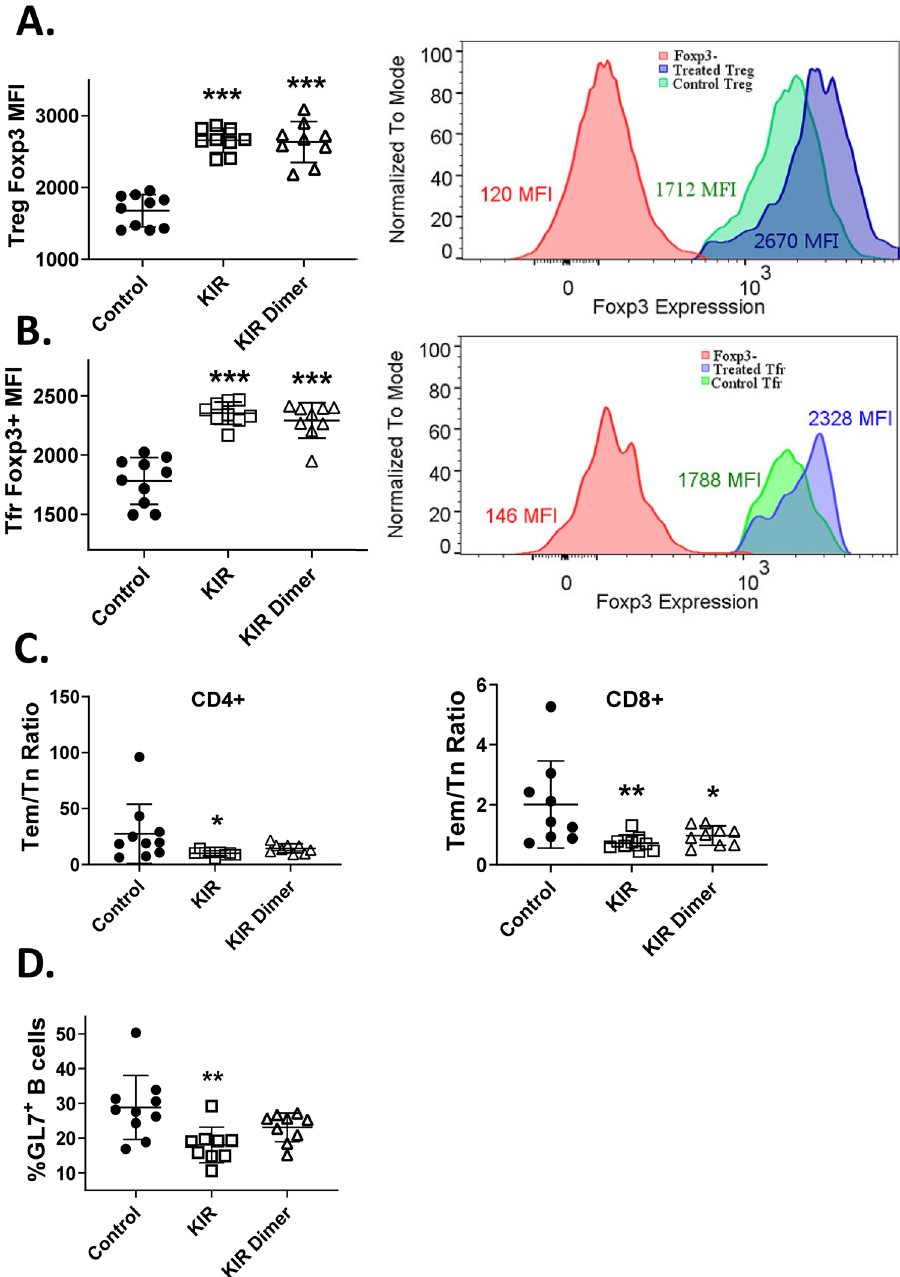
( B ) CD4 + T follicular regulatory cells [CD4 + PD1 + CXCR5 + Bcl6 + Foxp3 + ] were analyzed by flow cytometry. ( C ) Ratio of CD4 + and CD8 + effector memory (CD44 + CD62L − ) to naïve T cells (CD44 − CD62L + ). ( D ) Frequency of Germinal Center B cells (CD19 + GL7 + ) and CD80 + Plasma cells (CD19 − CD138 + ). Each cohort had 9–10 animals. (Error bars, SD) *p < 0.05, **p < 0.01, ***p < 0.001 (One-way ANOVA followed by dunnett’s multiple comparison test)]. The histograms were prepared in FlowJo v10 [https:// www. flowjo. com/ solut ions/ flowjo].